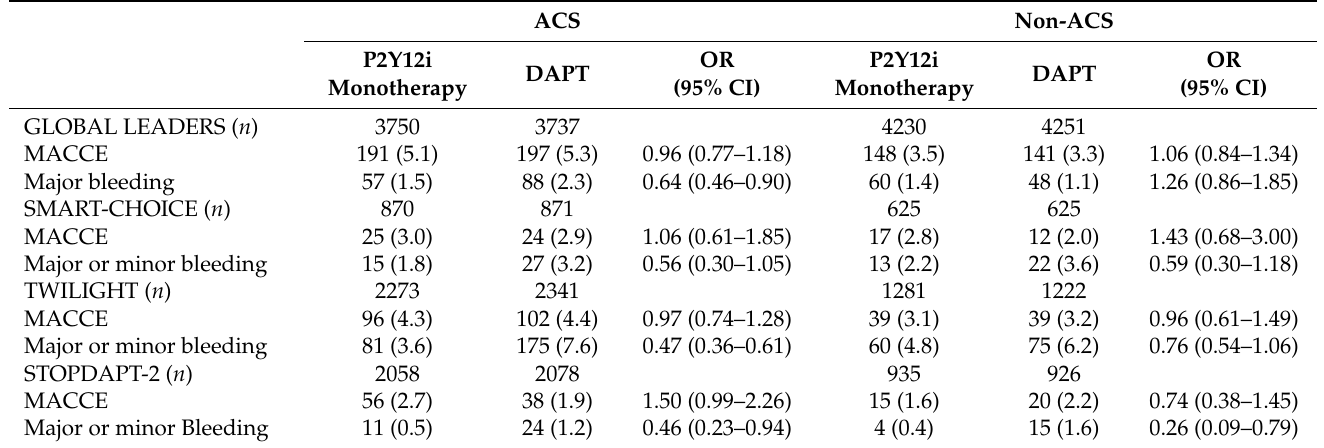
Table 3. The efficacy and safety outcomes of P2Y12 inhibitor monotherapy in ACS versus non-ACS patients of included trials.